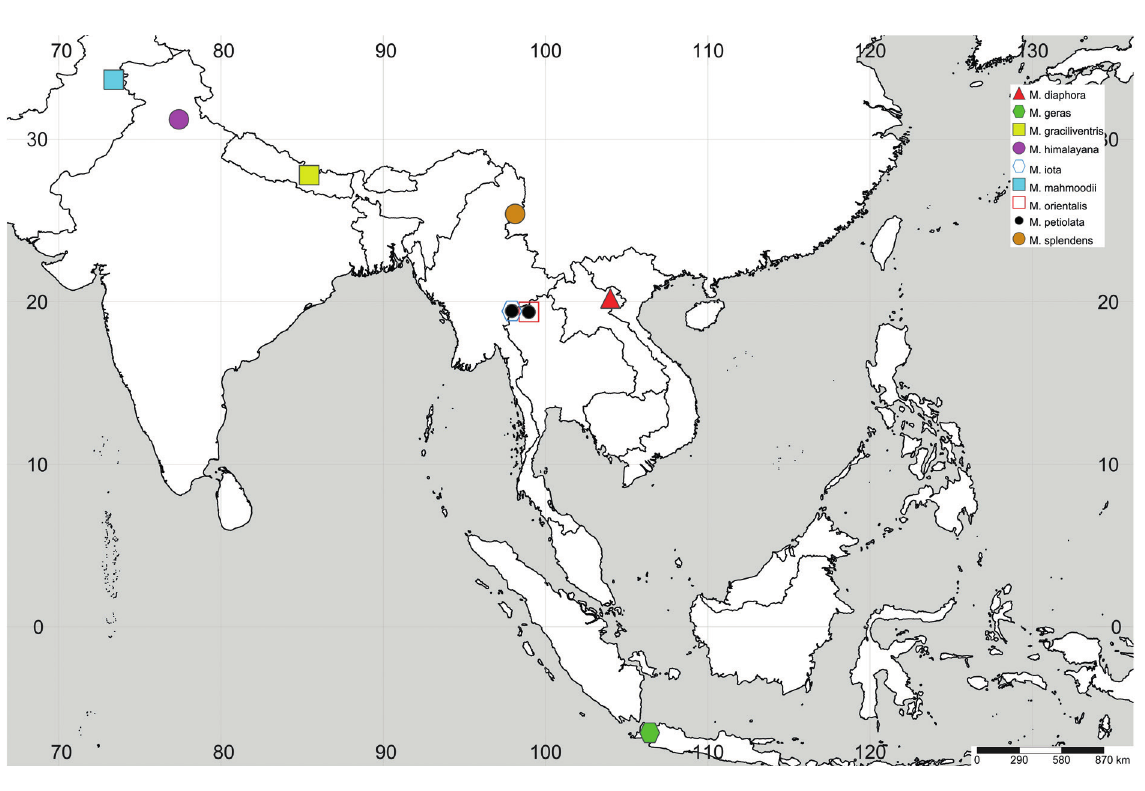
Fig. 1. Geographic distribution of the species of Myolepta in the Indomalayan Realm: M. diaphora sp. nov. (red triangle), M. geras sp. nov. (green hexagon), M. graciliventris Wiegmann, 1986 (yellow square), M. himalayana Brunetti, 1915 (pink circle), M. iota sp. nov. (blue open hexagon), M. mahmoodii Hassan & Bodlah, 2021 (light blue square), M. orientalis Thompson, 1971 (red open square), M. petiolata Thompson, 1971 (black circle), and M. splendens Thompson, 2014 (light brown